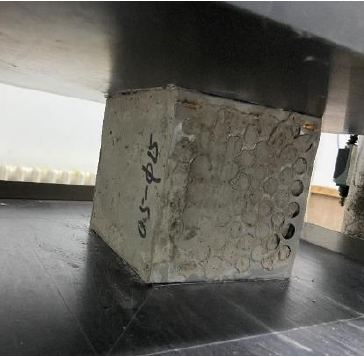
Figure 5. One-way compression test.